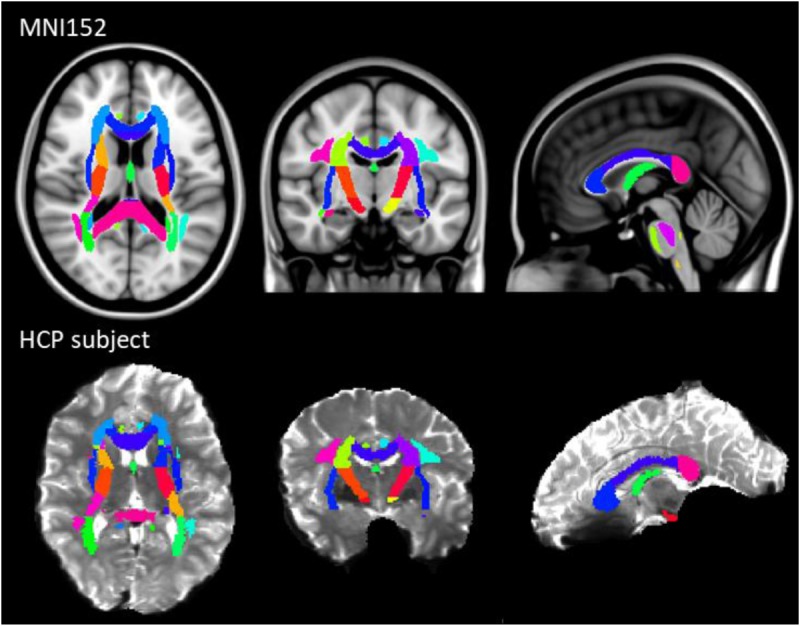
JHU-ICBM-DTI-48 white-matter atlas displayed in the MNI standard coordinate space (top) and registered into the diffusion space of an individual after ECCAR correction (HS pipeline) (bottom). 38 out of the 48 ROIs were included in the image. Note that even in the case of the simplest correction pipeline, the central brain regions are properly aligned with the subject’s anatomy.